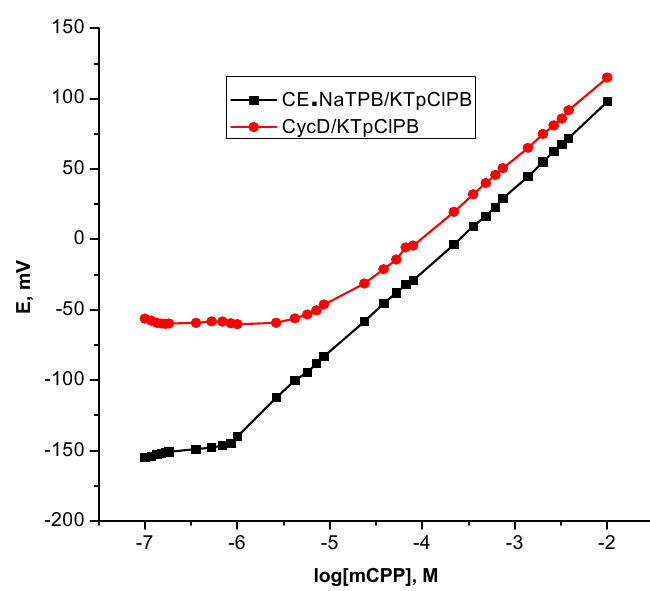
Figure 3. Calibration plots for m-chlorophenylpiperazine polymeric membrane based sensors.